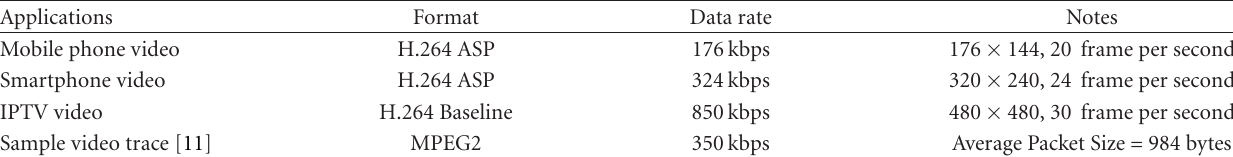
Table 6: Mobile TV workload parameters [12].